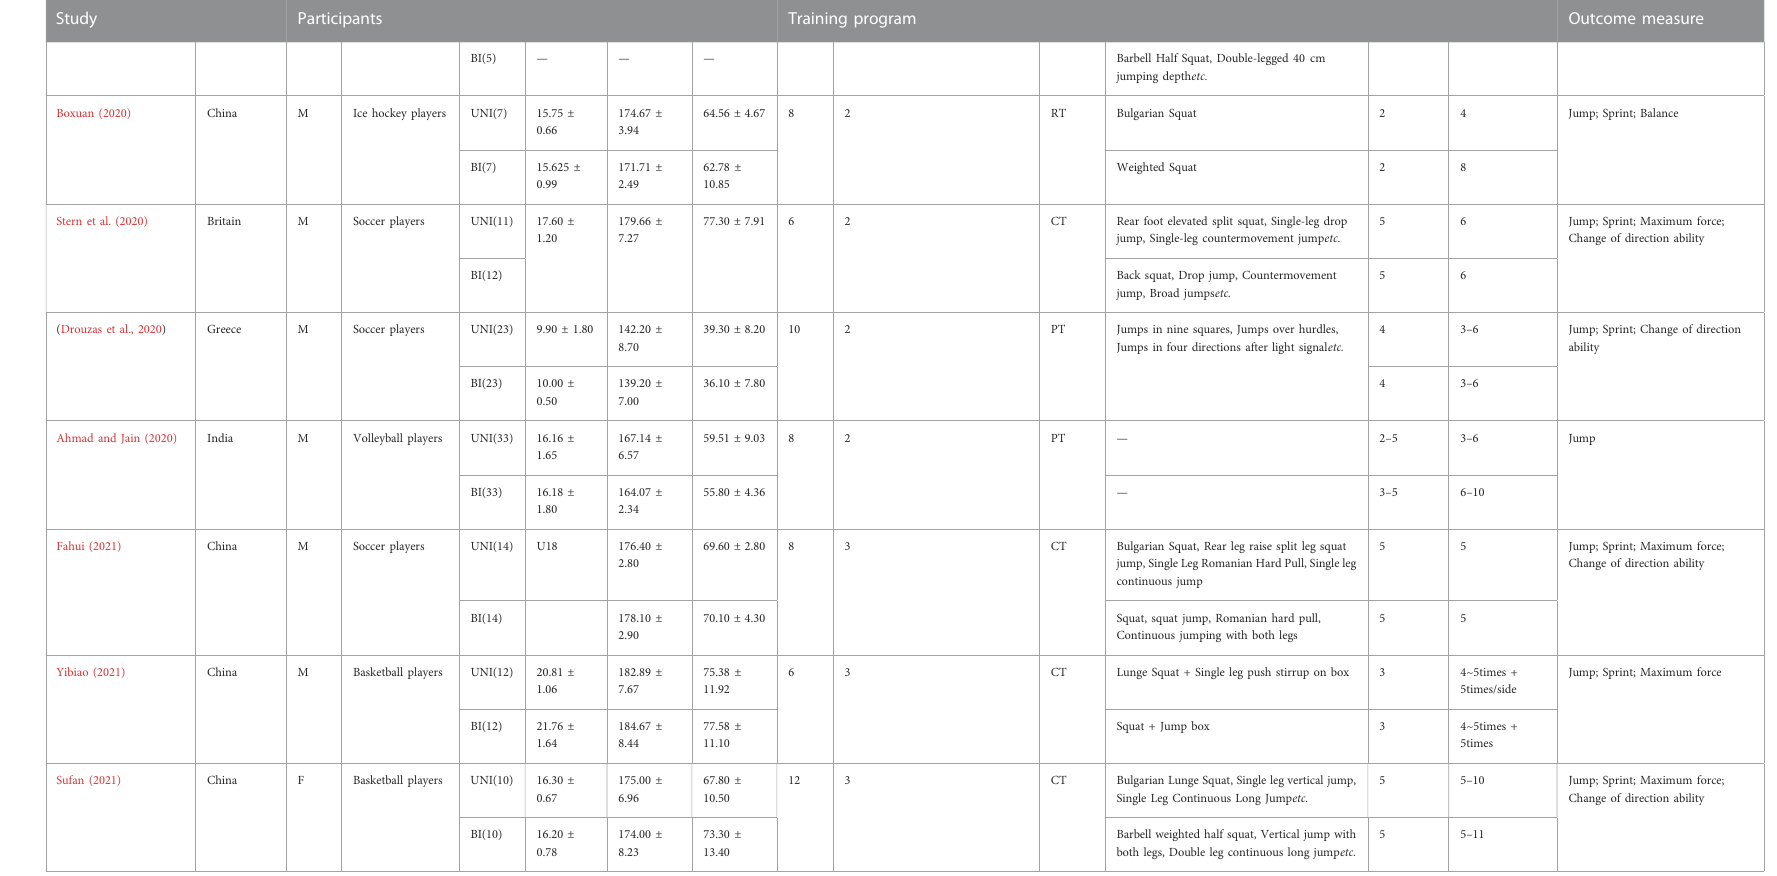
Abbreviations: M = male; F = female; RT, resistance training; PT, plyometric training; CT, complex training; EOT, Eccentric-overload